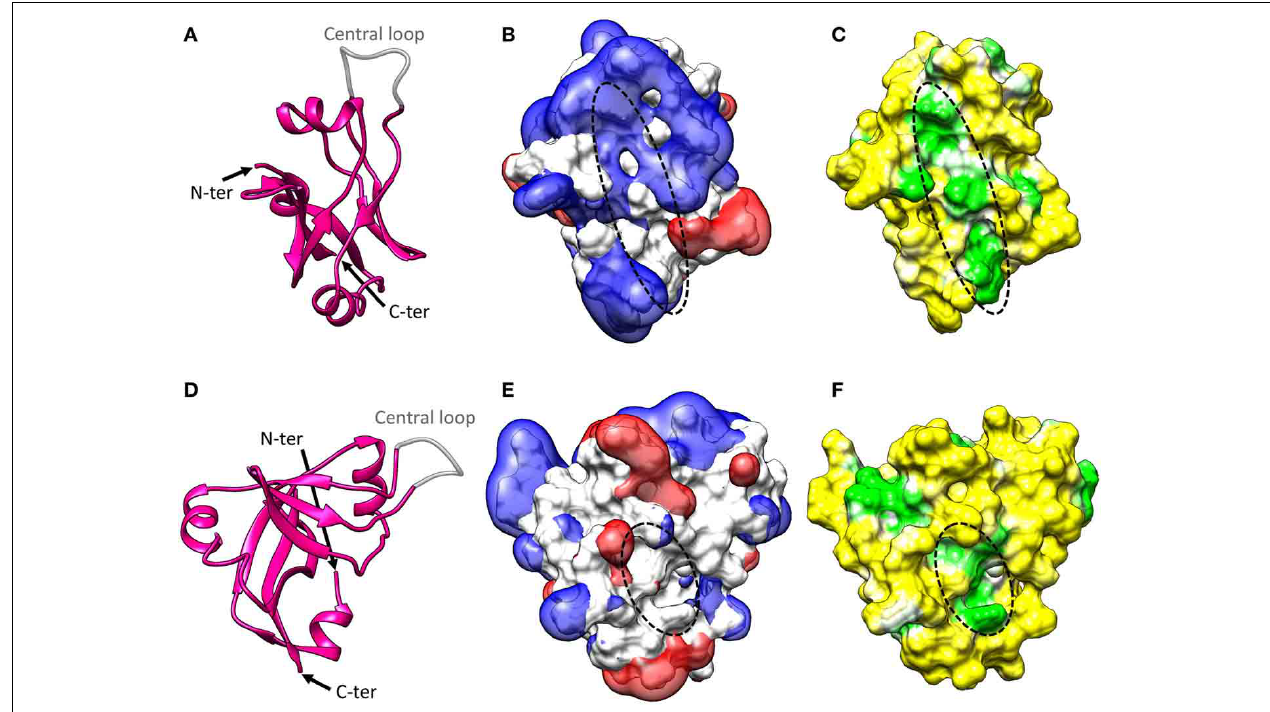
FIGURE 3 | SmpB structure. (A) Cartoon representation of the crystal structure of Thermus thermophilus SmpB (PDB entry: 1WJX). The N-terminal end, C-terminal end, and central loop are indicated. SmpB adopts an oligonucleotide-binding fold (OB fold) with a central β -barrel and three flanking α -helices. The C-terminal tail is unstructured in solution but folds into a fourth α -helix once SmpB is inserted into the ribosome. The central loop is disordered in the crystal, suggesting that it must be flexible when the protein is alone. (B) Electrostatic potential of SmpB. Two isocontours at − 1V (red) and + 1V (blue) are represented with the solvent-accessible surface of SmpB (white). The potential was calculated using the APBS program (Baker et al., 2001) with CHARMM force field parameters and an ionic strength of 50mM. The primary